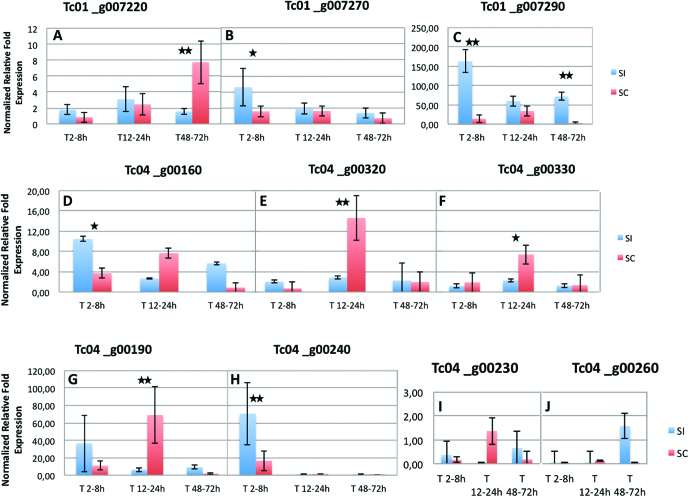
Relative expression of T. cacao CH1 and CH4 candidate genes differentially expressed during SI and SC reactions. The expression of 10 candidate genes was analysed by qPCR at several time points after SI and SC pollinations: 2–5–8 h, 12–24 h, and 48–72 h. Data are relative expression, in relation to unpollinated ovules, after normalization against two housekeeping genes. (A) Tc01_g0007220, orthologous to a leucine-rich repeat receptor-like serine/threonine-protein kinase BAM1; (B) Tc01_g0007270, orthologous to a transducin WD-40 repeat-containing protein; (C) Tc01_g007290, orthologous to a putative transmembrane transporter; (D) Tc01_g000160, orthologous to a voltage-dependent L-type calcium channel; (E) Tc04_g000320, orthologous to a zinc finger AN1 transcription factor; and (F) Tc04_g000330, orthologous to an ARM repeat-containing protein ARC1. (G–J) Orthologous to GEX1 genes: (G) Tc04_g000190, (H) Tc04_g000240, (I) Tc04_g000230, and (J) Tc04_g000260. Differential expression was tested by Fisher’s exact test: *P<0.05, **P<0.01.